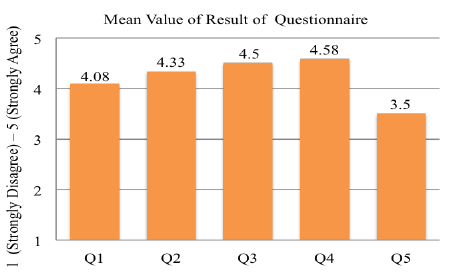
Figure 11. The result of usefulness questionnaire of